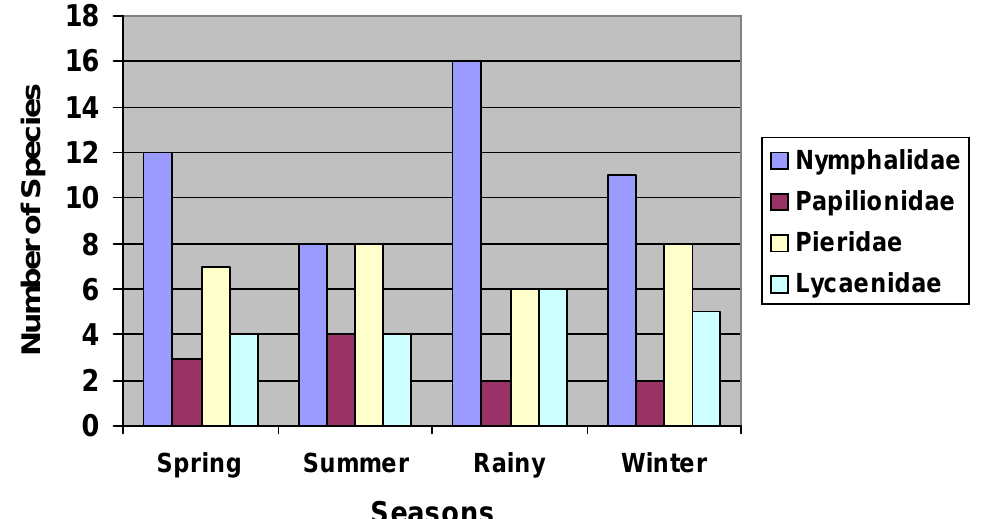
Figure 2. Diversity of Nymphalidae, Papilionidae, Pieridae and Lycaenidae across the 4 seasons (Spring, Summer, Rainy and Winter)